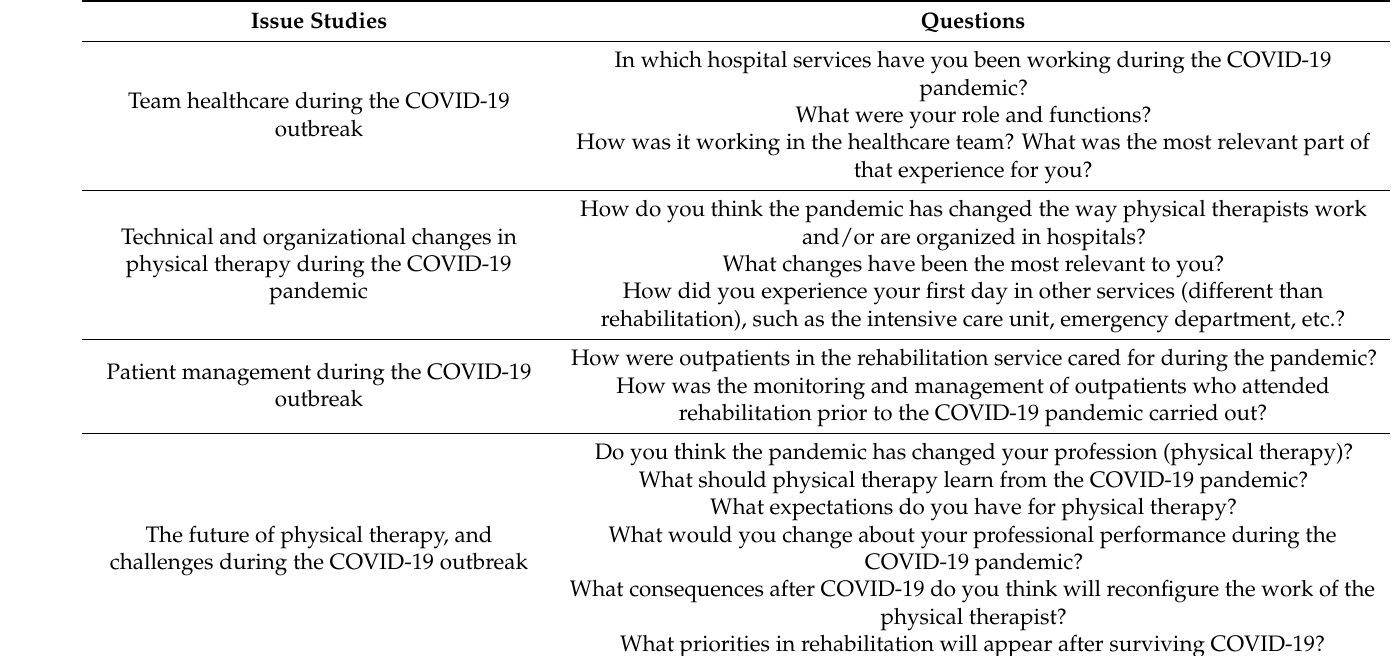
Table 1. Semi-structured question